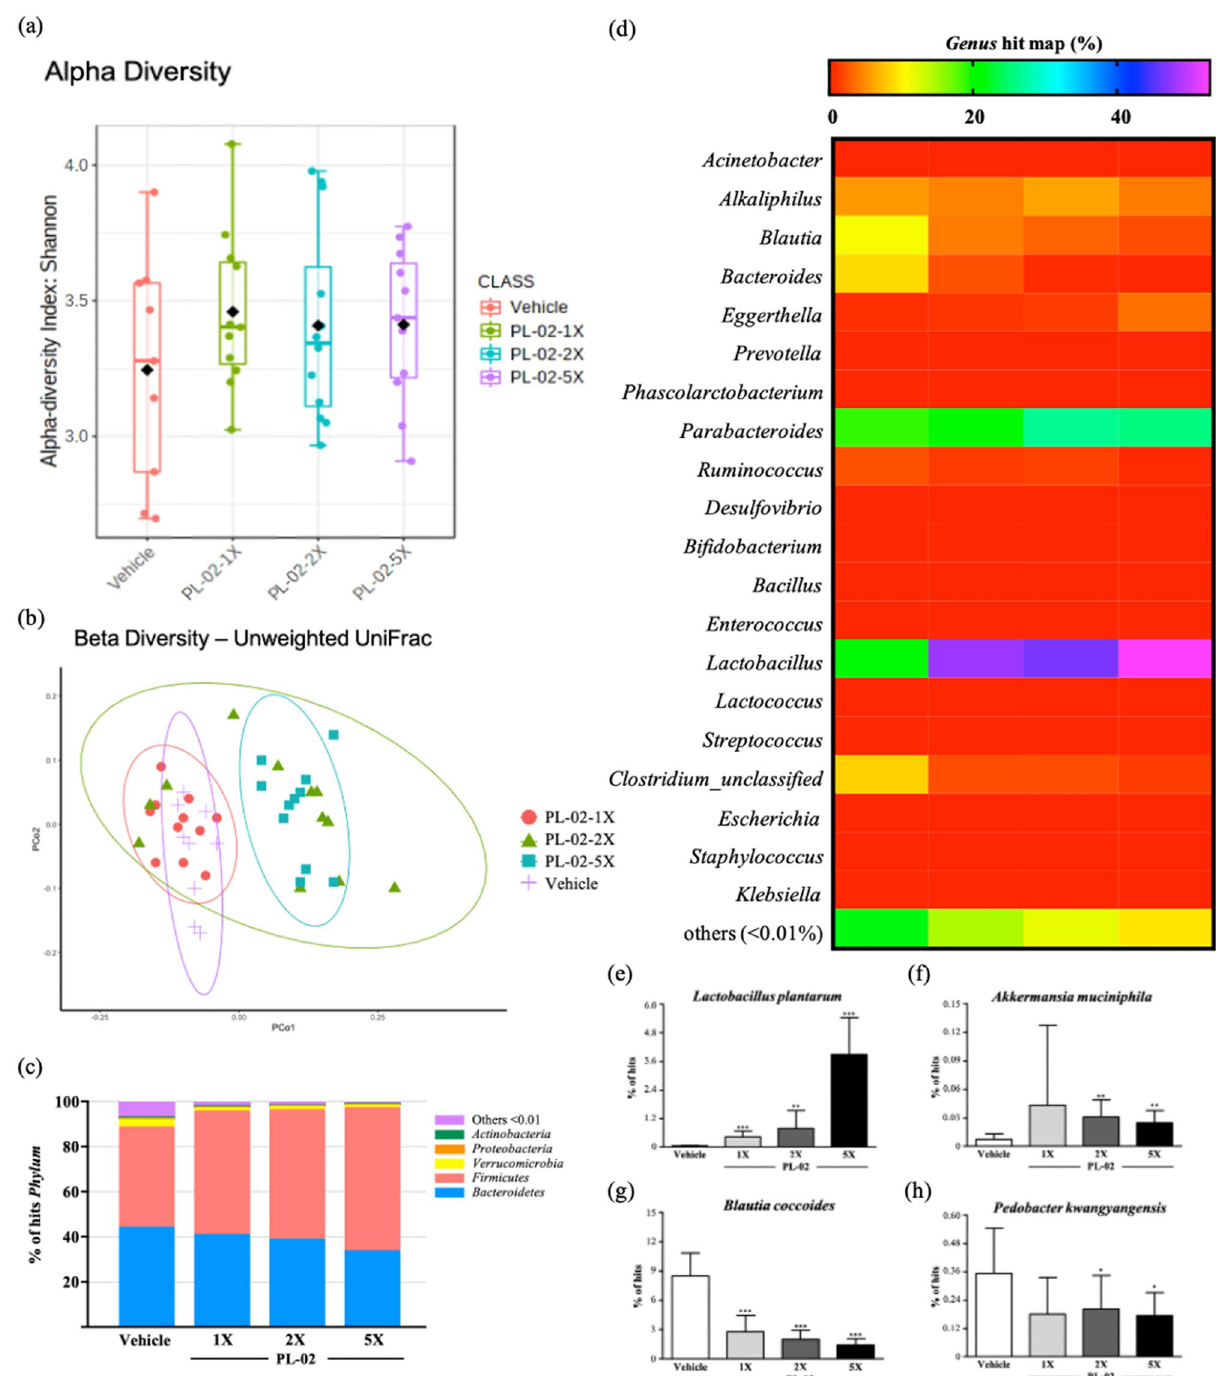
Figure 5. Effect of PL-02 supplementation on ( a ) alpha diversity, ( b ) beta diversity, ( c ) phylum , ( d ) genus , ( e ) Lactobacillus plantarum % hits, ( f ) Akkermansia muciniphila. % hits, ( g ) Blautia coccoides % hits , and ( h ) Pedobacter kwangyangensis % hits . Data are expressed as mean ± SD for n = 8 mice per group. Values with different superscript letters are significantly different at * p < 0.05; ** p < 0.01; *** p <